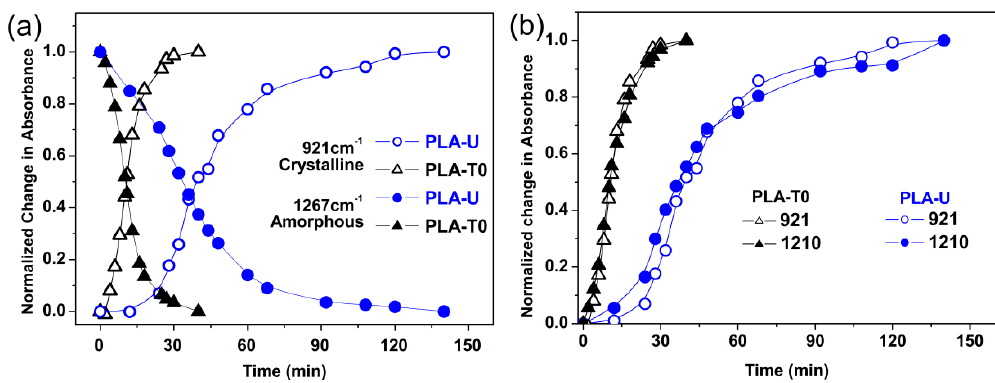
Figure 3. Time-resolved FTIR spectra in the 1500 − 830 cm − 1 ( a , c ) and 970 − 850 cm − 1 ( b , d ) ranges for PLA-U ( a , b ) and PLA-T0 ( c , d ) during the isothermal crystallization at 110 °C.